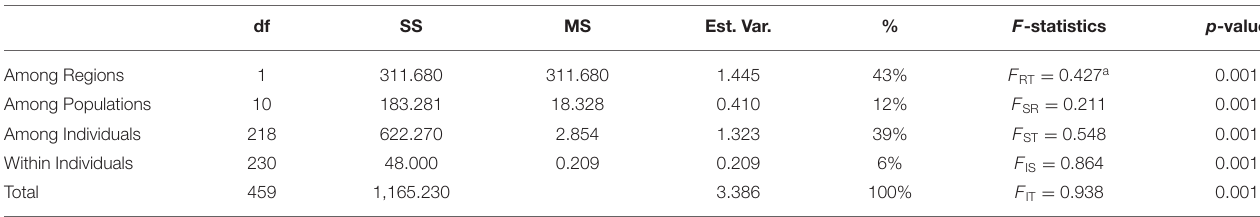
TABLE 3 | Summary of AMOVA and hierarchical F -statistics of Ruppia brevipedunculata (df, degrees of freedom; SS, sum of squares; MS, mean of squares; % Est.Var., estimated variance). df SS MS Est.